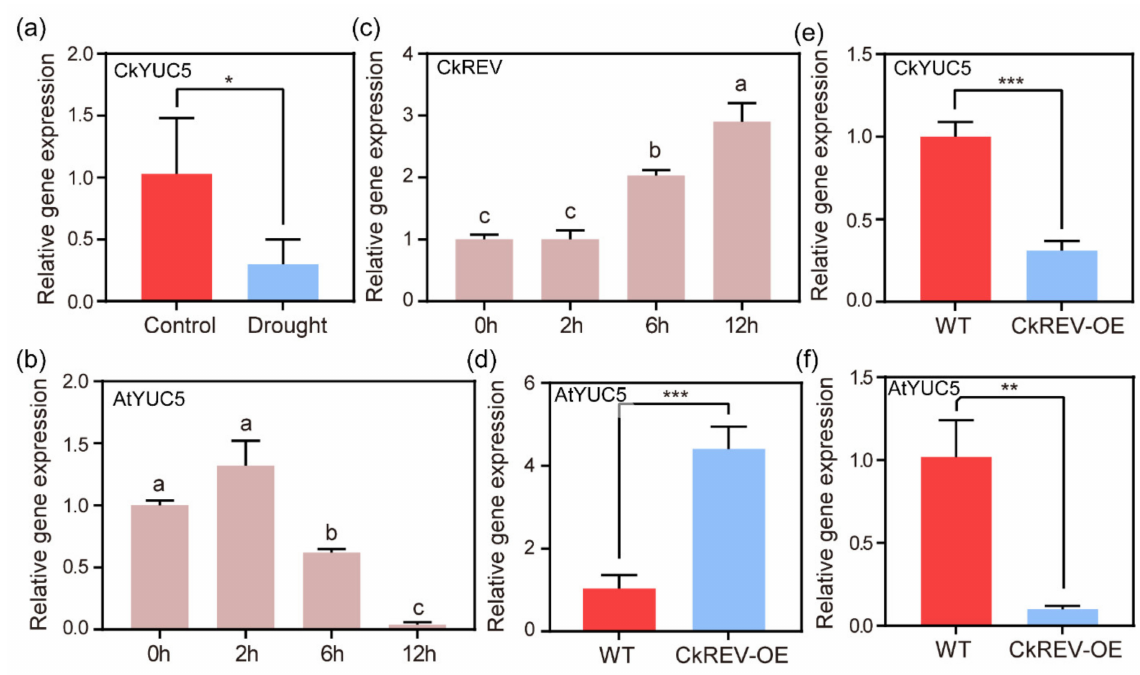
Figure 4. qRT–PCR analysis on the expression level of relevant genes. ( a ) Analysis of the expression level of CkYUC5 in C. korshinskii leaves after natural drought treatment; ( b ) Analysis of the expression level of AtYUC5 in A. thaliana seedlings after cultured on 1/2 MS medium for 7 days and transferred to PEG medium for simulated drought treatment; ( c ) Analysis of the expression level of CkREV in hydroponic C. korshinskii after drought simulation on PEG medium; ( d ) Analysis of the expression level of AtYUC5 in A. thaliana CkREV –OE lines at the age of 4 weeks; ( e ) Analysis of the expression level of CkYUC5 in C. korshinskii leaves instantaneously overexpressing CkREV; ( f ) Analysis of the expression level of AtYUC5 in wild type and transgenic A. thaliana after drought treatment. ( a , d – f ) Data are shown as the mean ± SD of three independent experiments. Student’s t –test is employed to measure statistical significance between two samples with confidence level at 0.95 (*, p < 0.05; **, p < 0.01; ***, p < 0.001). ( b,c ) Data are shown as the mean ± SD of three independent experiments. One–way ANOVA was performed for the statistical analysis, where different letters represent significant differences ( p <